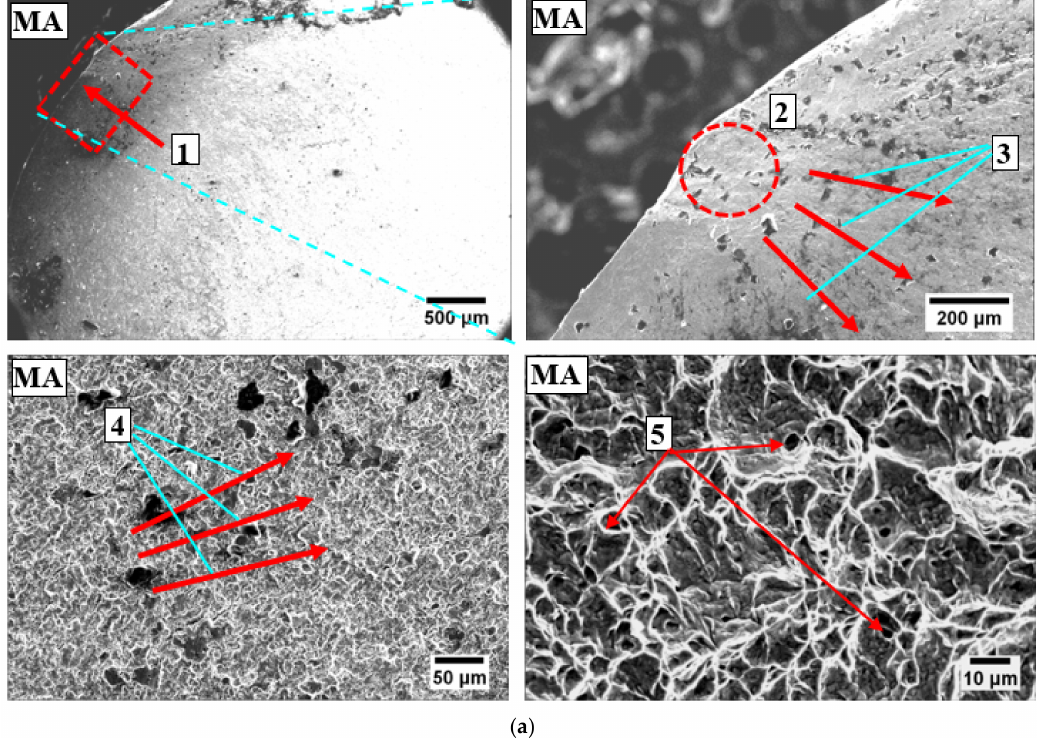
Figure4. HCFmeanresultsandstandarddeviation(fordatadispersion)ofB1, B2andMATi-6Al-4VELI. Figure 4. HCF mean results and standard deviation (for data dispersion) of B1, B2 and MA Ti-6Al-4V ELI.